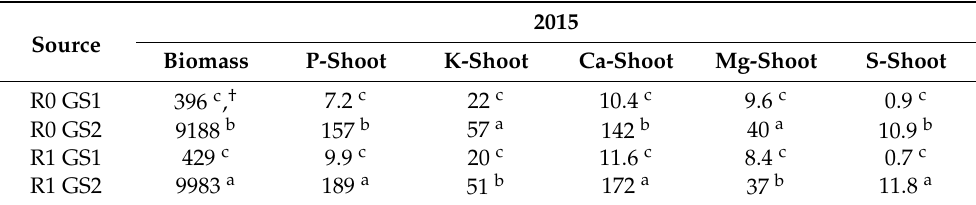
Table A7. Biomass accumulation and biomass P, K, Ca, Mg, and S accumulation in 2015 as a function of residue management and growth